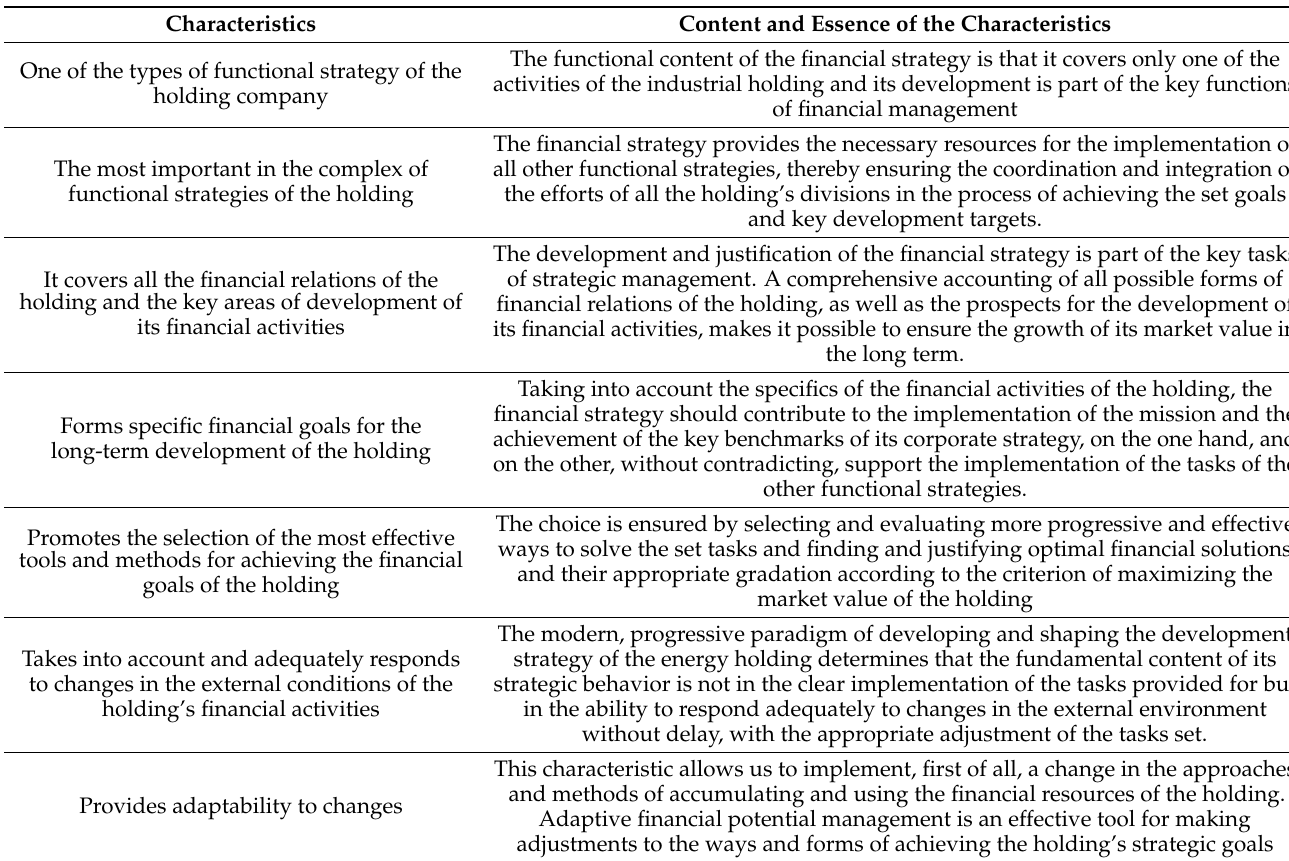
Table 1. Key content characteristics of the energy holding’s financial